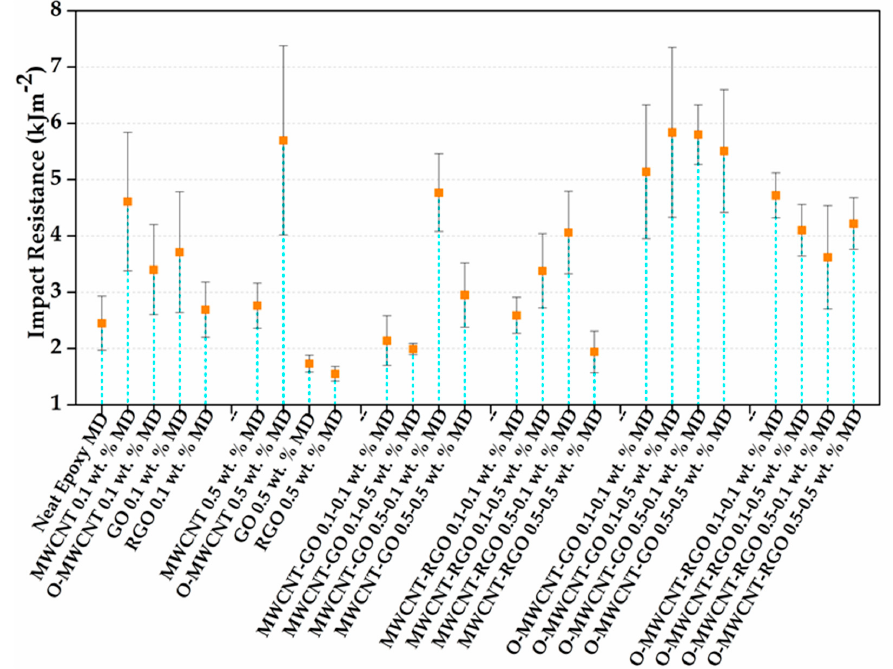
Figure 5. Izod impact resistance values for multidimensional nanocomposites.